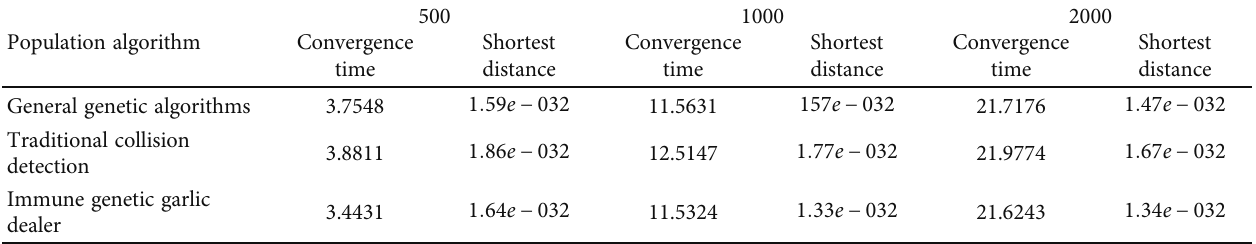
Table 1: The simulation results of the algorithm when the population is 500, 1000, and 2000. Population algorithm